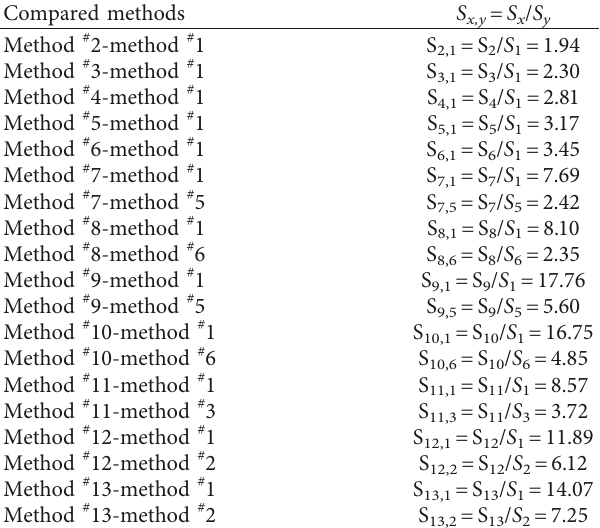
Table 19: Relative performance index-based comparison between some considered identification methods for process P 1,5 .